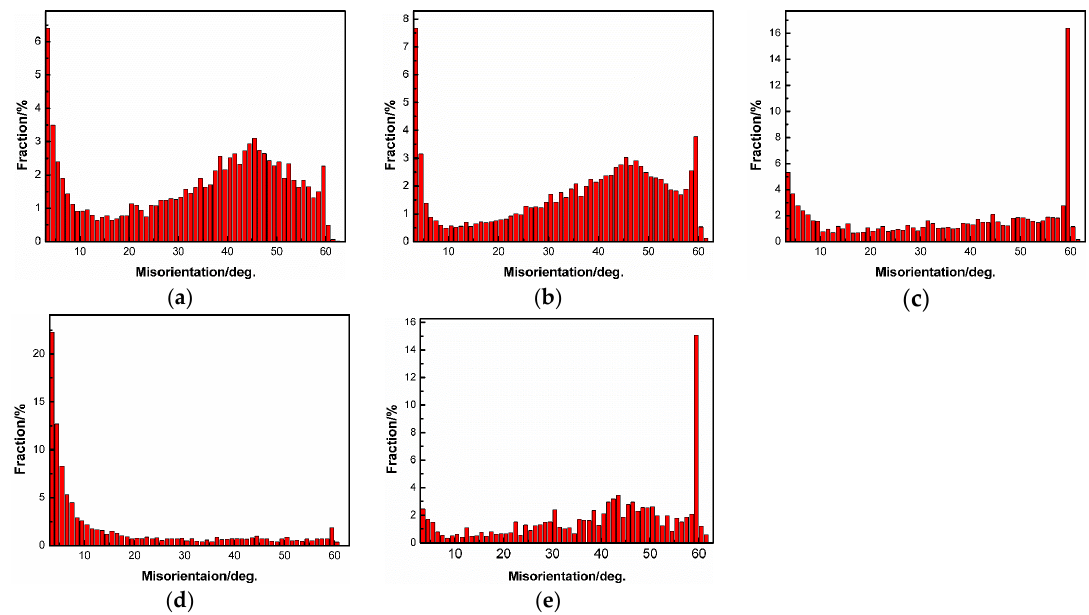
Figure 8. Misorientation angle distribution of deformed samples at different conditions: ( a ) 1000 °C, 0.01 s − 1 ; ( b ) 1100 °C, 0.01 s − 1 ; ( c ) 1200 °C, 0.01 s − 1 ; ( d ) 1200 °C, 0.1 s − 1 ; ( e ) 1200 °C, 0.001 s − 1 .